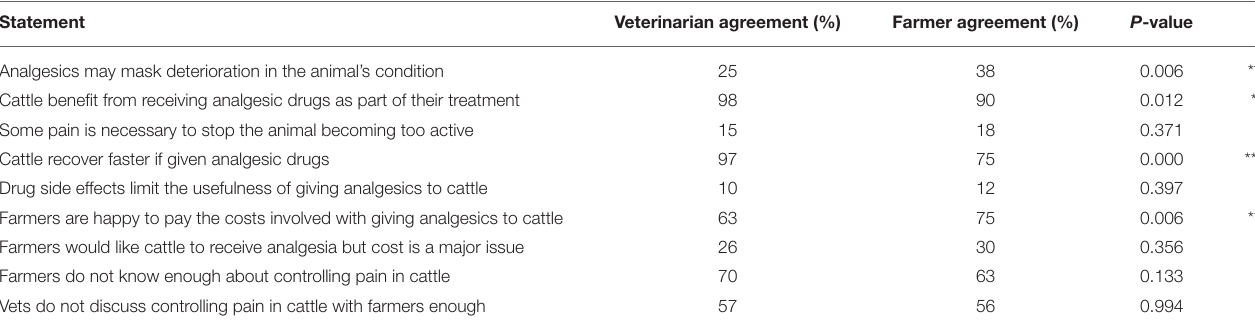
TABLE 2 | The agreement of farmers and veterinarians with statements relating to analgesia and pain in cattle, in a survey investigating attitudes to pain and analgesic use in pasture-based dairy